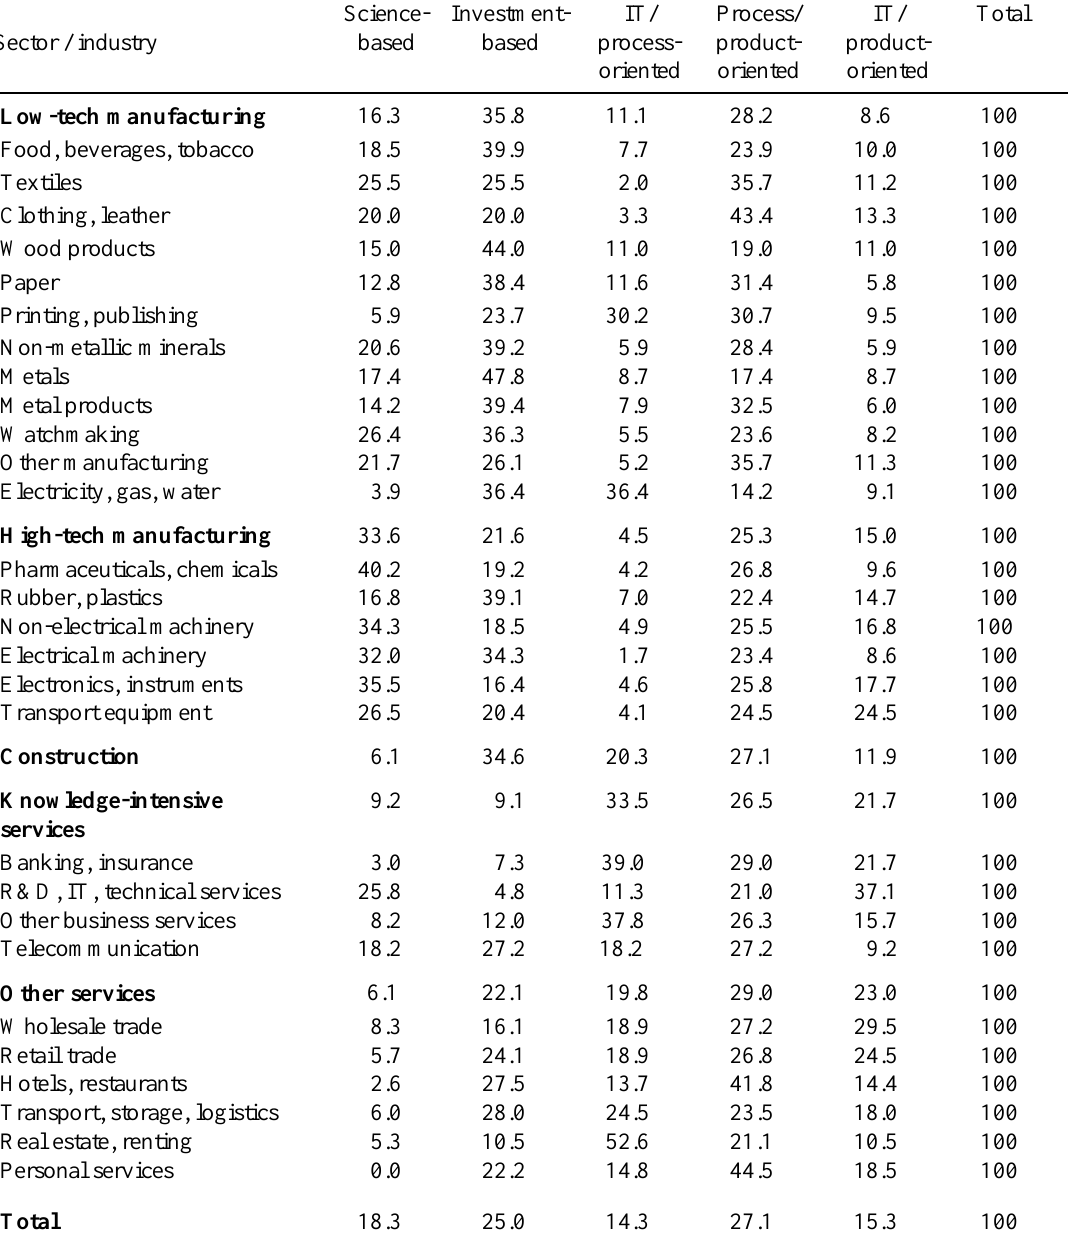
Table 7 : Intra-industry distribution of firms by